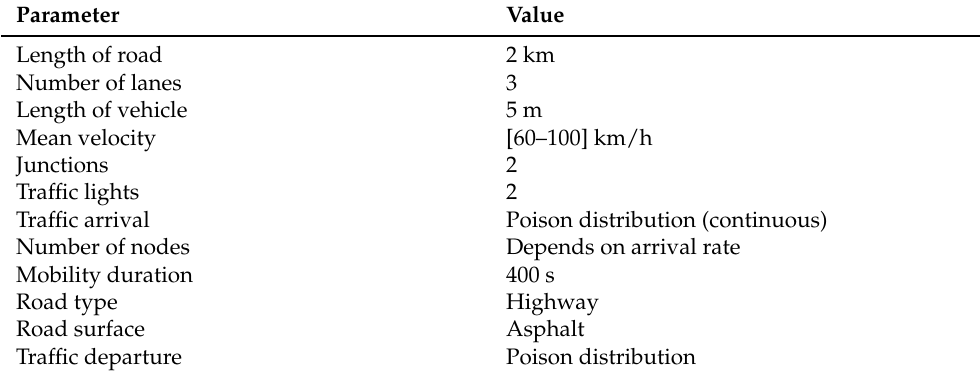
Table 1. Traffic simulation specification.